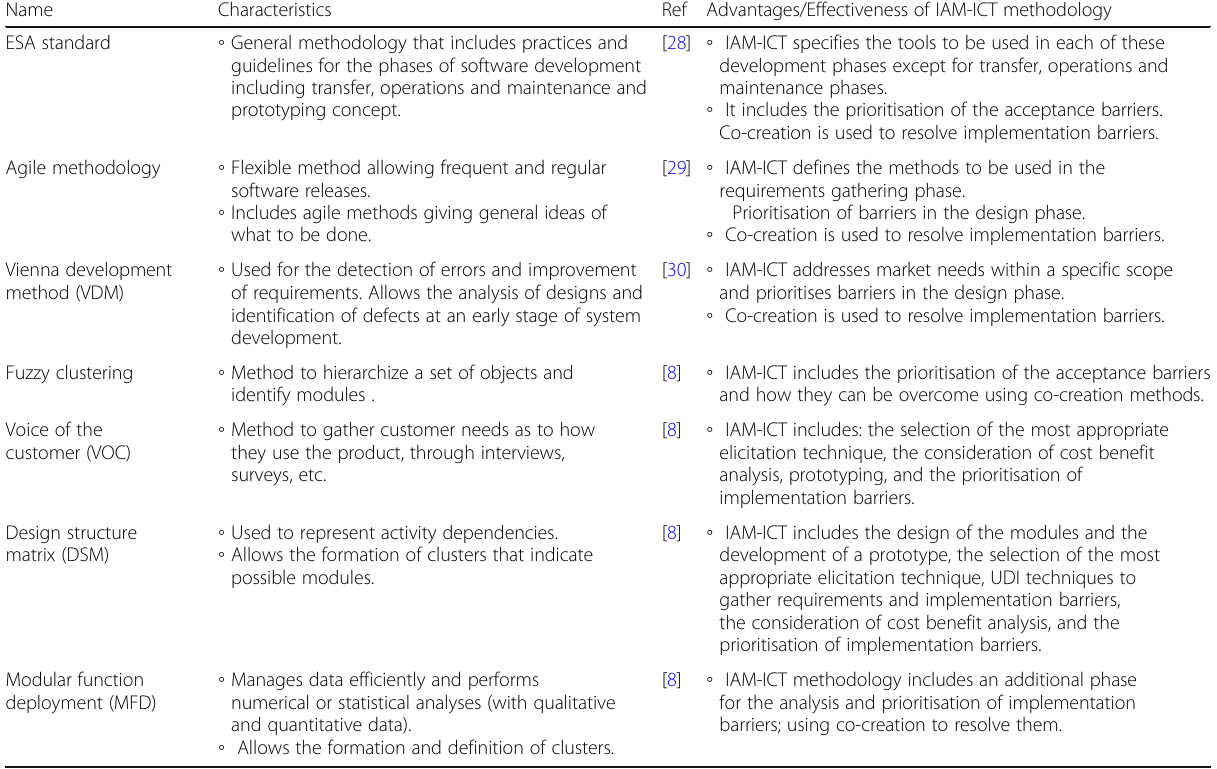
Table 1 Comparison of current methodologies and IAM-ICT methodology, and impact on its effectiveness in the implementation of innovative